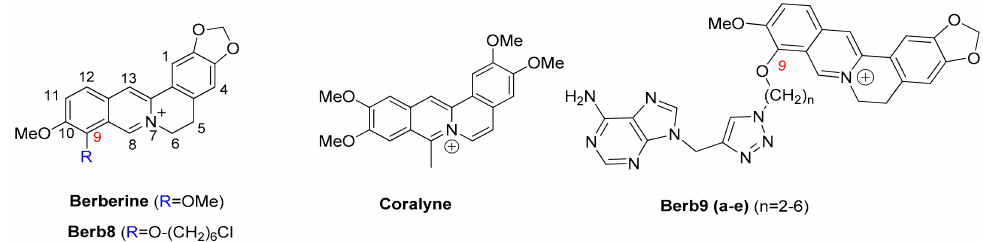
Figure 13. Structures of the G4 stabilizers Berberine, Berb8, Coralyne and Berb9 (a-e). To enhance the interaction of ligands with G4, 9- O -alkylamine or 9- N -alkylamine berberine derivatives were synthesized. The results showed that berberine and its 9- O - substituted derivatives could induce and stabilize the anti-parallel G4 of telomeric DNA d[G3(T2AG3) 3 ] (telo21), in the presence or absence of metal cations. When compared to berberine, these 9- O derivatives, exhibit stronger binding affinity to G4 and